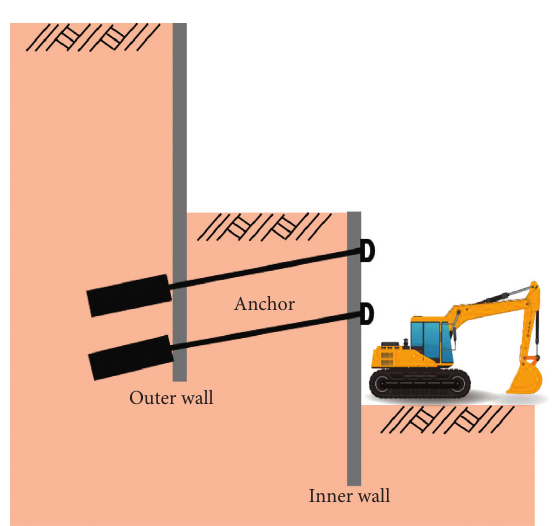
Figure 2: Image of anchor construction (cross